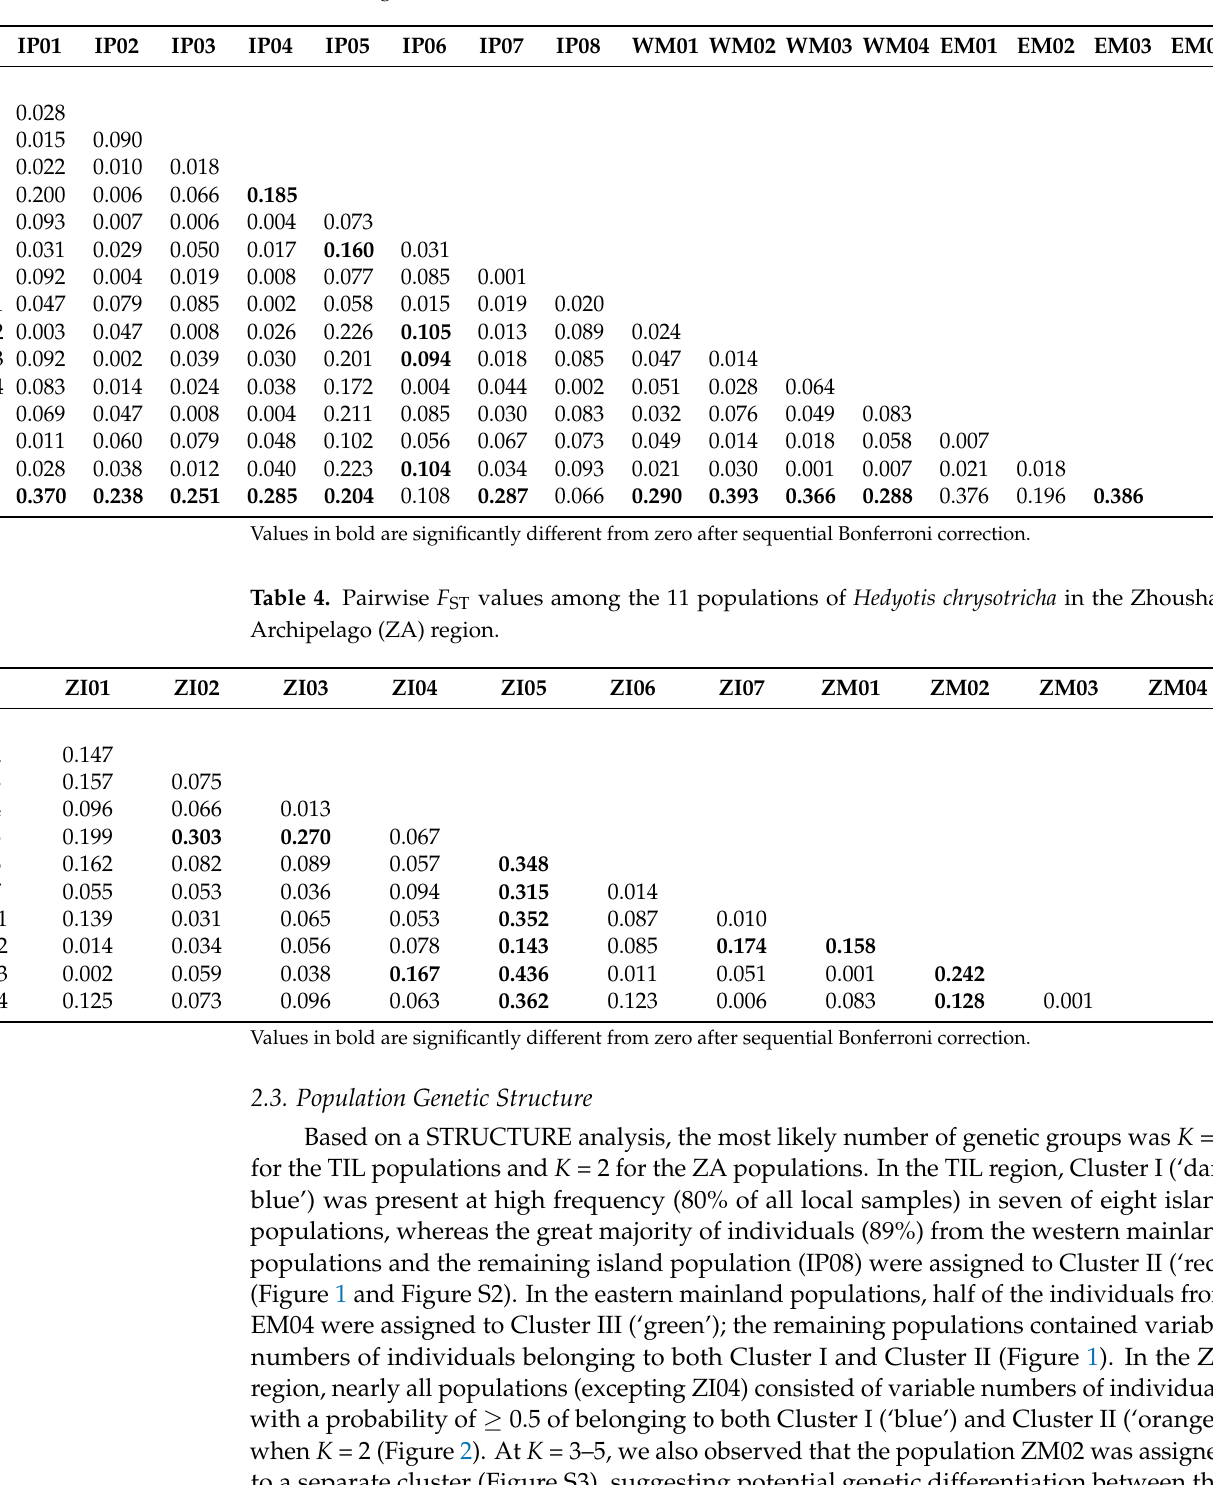
Table 3. Pairwise F ST values among the 16 populations of Hedyotis chrysotricha in the Thousand-Island Lake (TIL) region.